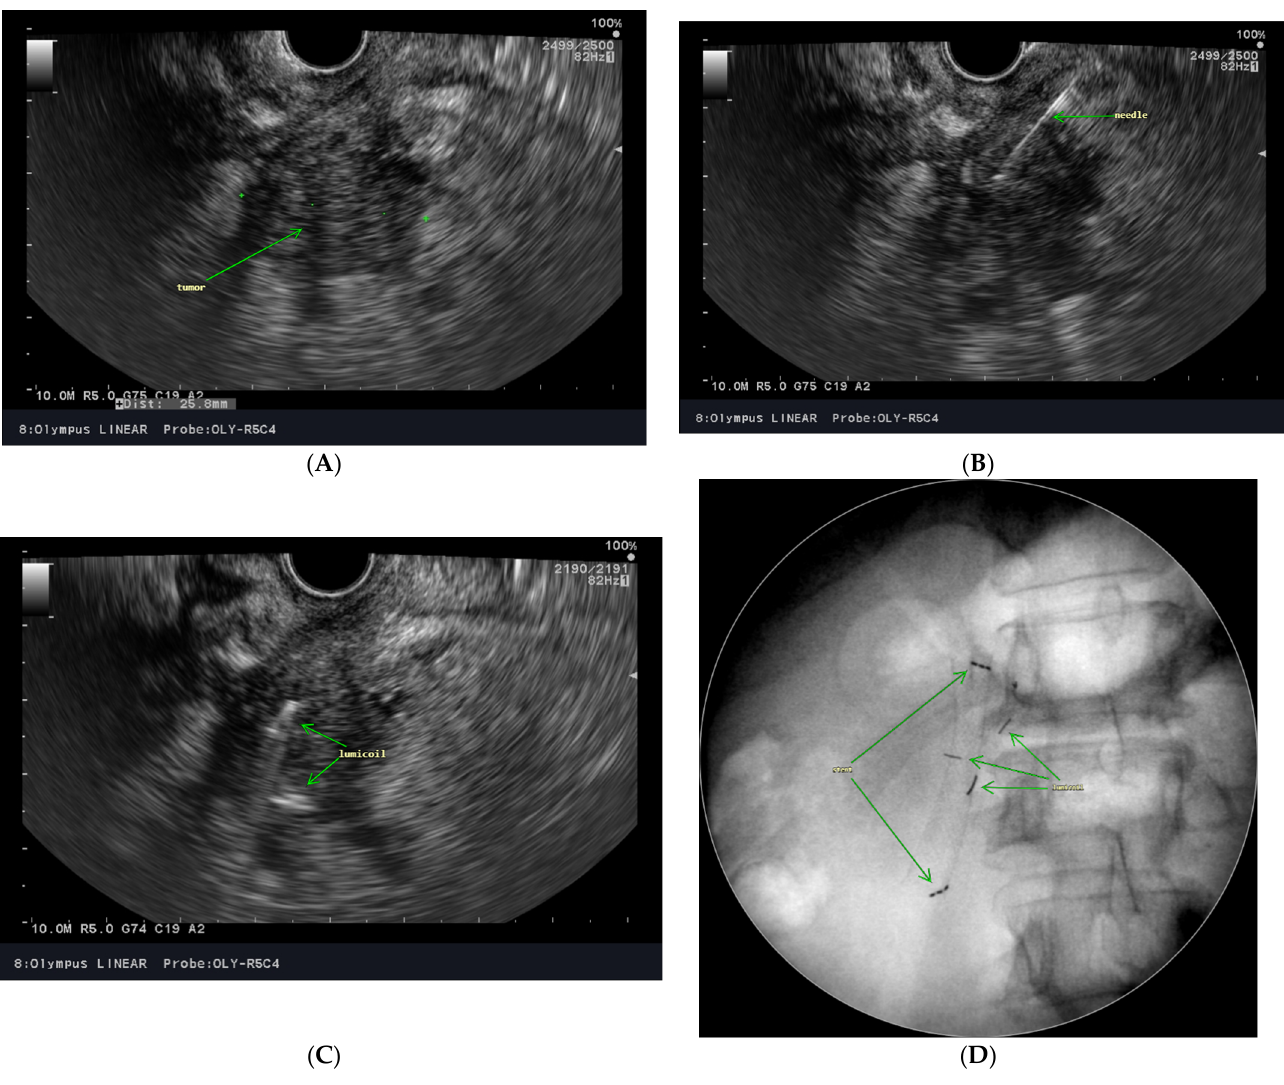
Figure 1. Endoscopic ultrasound-guided fiducial placement. Visualization of the tumor ( A ), needle trajectory ( B ), fiducial insertion ( C ), and control X-ray scan ( D ).